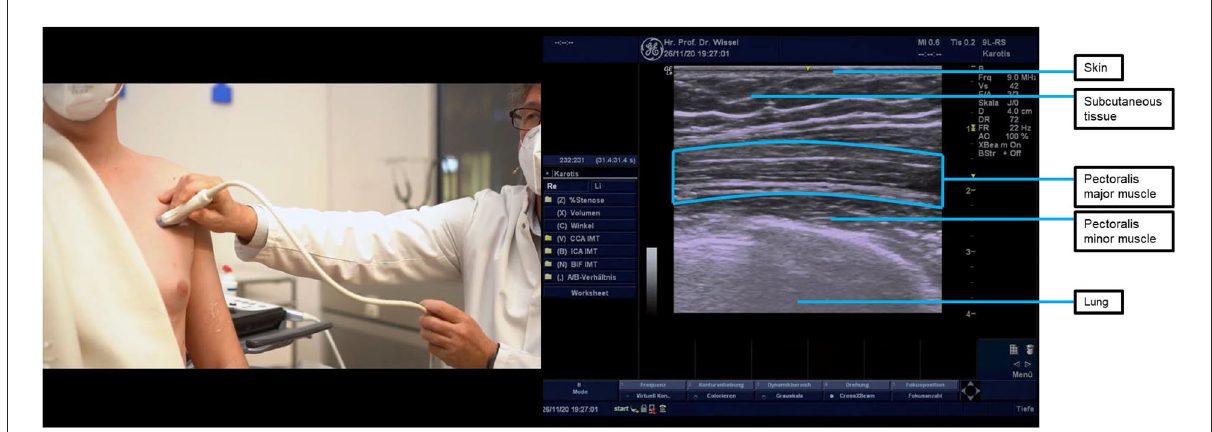
FIGURE1 Ultrasound probe placement and image of the pectoralis major muscle. The pectoralis major muscle is shown at the top of the ultrasound image separated by white “rips” (this fibrillar pattern indicates that the probe and muscle fibers are parallel to each other), and the pleura is shown at the bottom. Asking your patient to breathe in and out helps to identify the pleura which must be avoided when injecting. Turning the ultrasound probe through 90 degrees reveals the different fiber orientation of the pectoralis major and pectoralis minor muscles (pectoralis minor shown in the middle of the ultrasound image, which has small white dots—a starry sky appearance—indicating that the probe is somewhat perpendicular to the direction of muscle fibers.